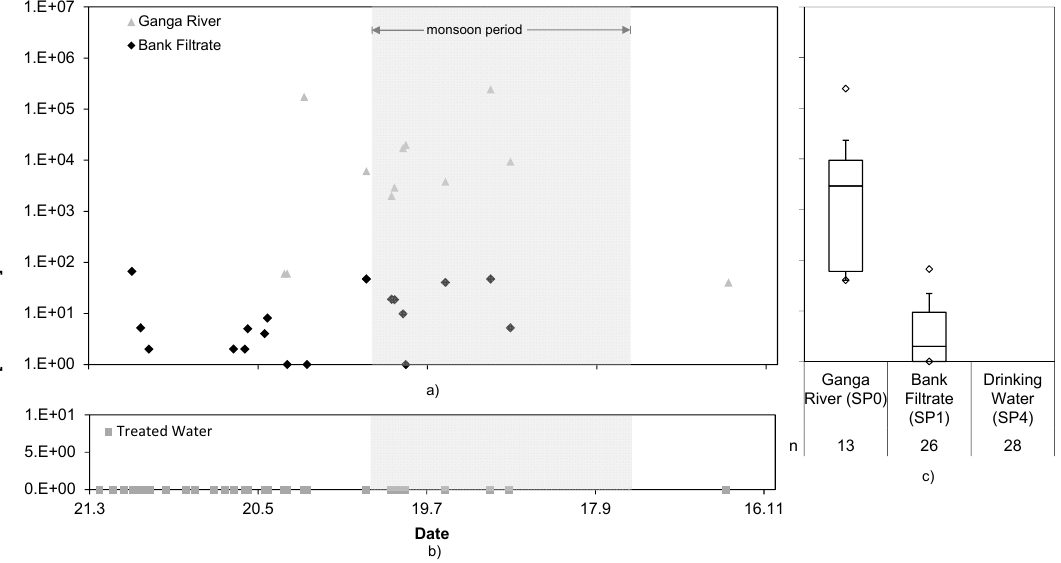
Figure 7. E. coli in the Ganga River water and bank filtrate ( a ) and drinking water ( b ), and statistical interpretation ( c ); trial period March–November.